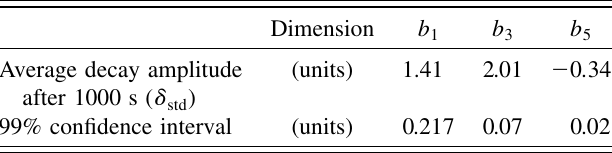
FIG. 2. (Color) The average decay amplitude of the main field and the harmonics after 1000 s. TABLE I. The average decay amplitude at 1000 s for the 352 apertures and the 99% confidence interval for the allowed harmonics.